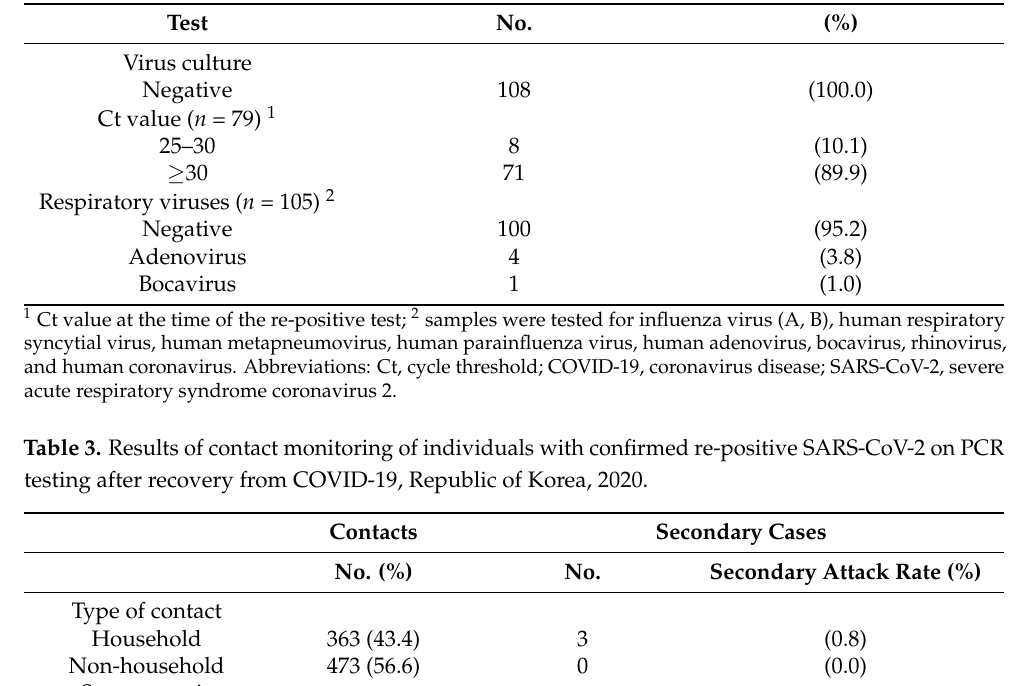
Table 2. Laboratory results of individuals with confirmed re-positive SARS-CoV-2 on PCR testing after recovery from COVID-19, Republic of Korea, 2020 ( n = 108).